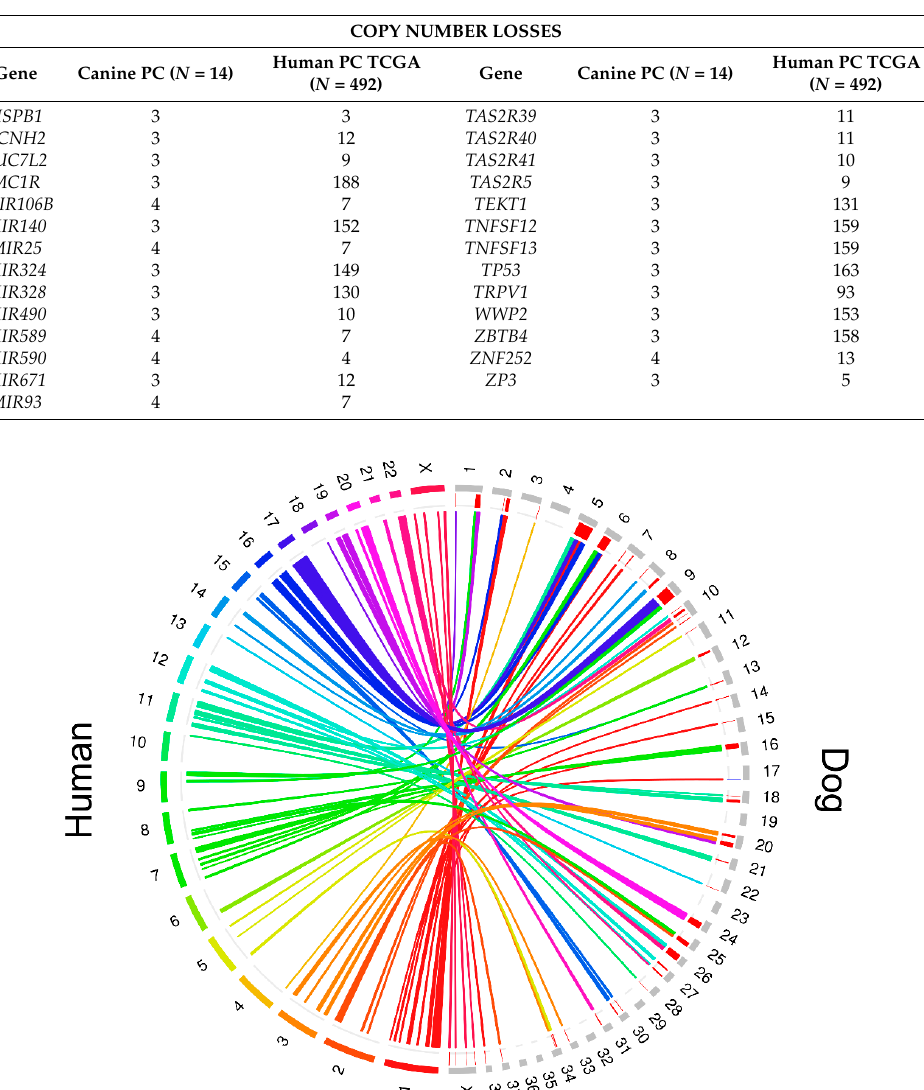
Figure 3. Circos plot showing recurrent copy number alteration (CNA) regions in canine prostate cancers (PCs), and the corresponding human chromosomal regions. The outer circle depicts canine (grey bars), and human chromosomes (colored bars). Regions of gains (blue), and losses (red) are shown between the outer and inner circles, below grey bars. The colored links indicate the corresponding regions involved in CNAs in dogs and